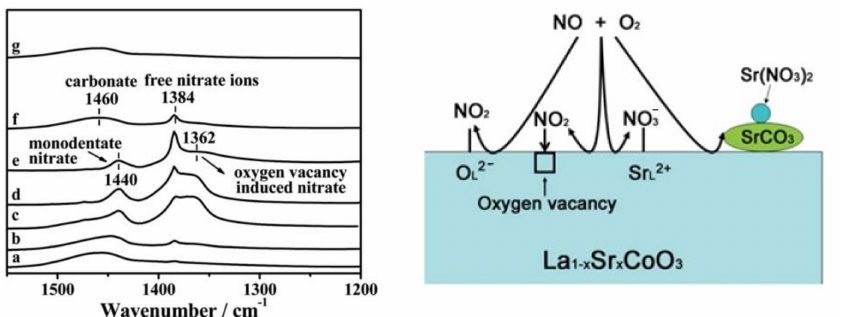
Figure 3. FT-IR spectra ( left ) of La 0.7 Sr 0.3 CoO 3 : fresh (a); after NO x storage at 200 ◦ C (b), 250 ◦ C (c), 300 ◦ C (d), 350 ◦ C (e), and 400 ◦ C (f); the sample (c) reduced by 5% H 2 at 300 ◦